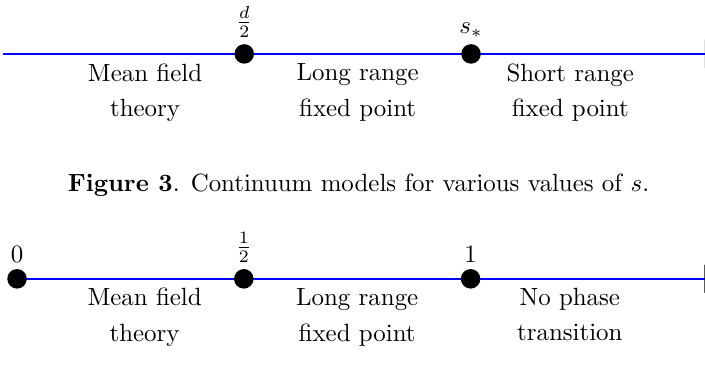
Figure 4 . Continuum picture for one dimensional O( N ) model for various s